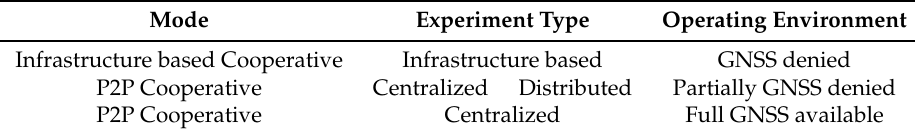
Table 4. Details of the experimental results presented in this